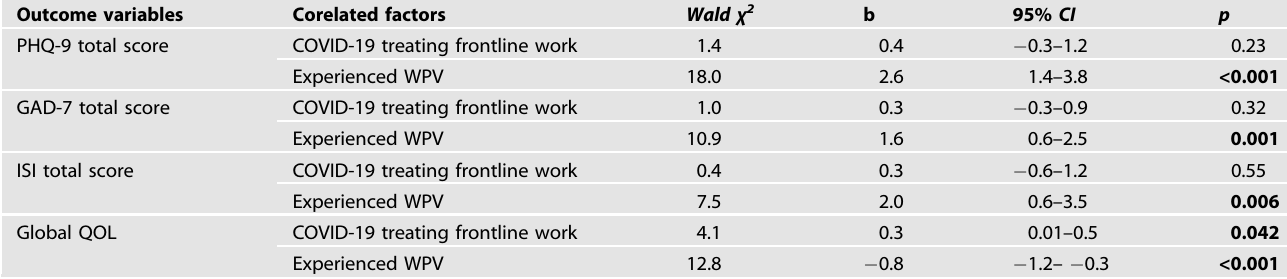
Bold values indicates statistical signi fi cant p values ( p <0.05) ; b unstandardized regression coef fi cient, CI con fi dence interval, COVID-19 coronavirus disease 2019, GAD-7 generalized anxiety disorder-7, GLM generalized linear model, PHQ-9 patient health questionnaire-9, QOL quality of life, ISI insomnia severity index, WPV workplace